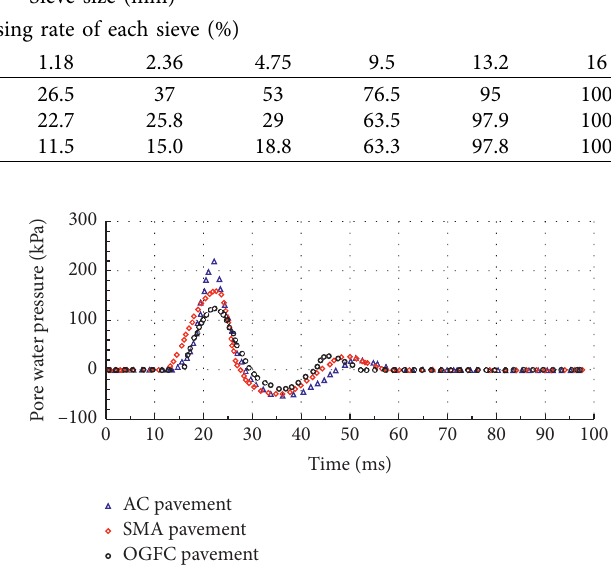
Figure 10: Pore water pressure varying with time for different kinds of asphalt